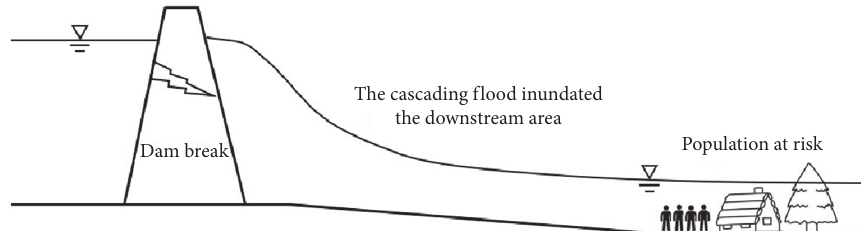
Figure 1: Life loss caused by dam-break flood sketch.